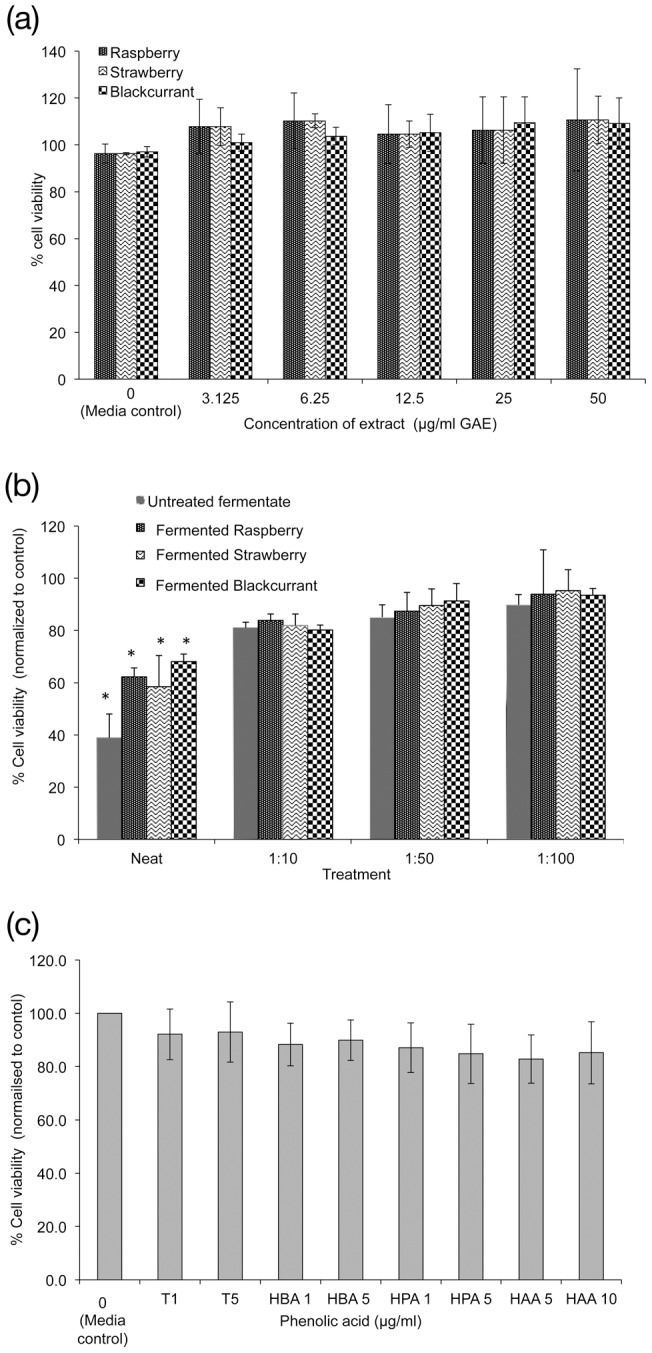
The cytotoxic effects of various types of berry extracts on HT29 cells.(A) Effects of IVD berry extract, (B) fermented berry extract at different dilutions in growth medium, (C) individual polyphenols- tyrosol (T), 3-(3′-hydroxyphenyl)propionic acid (HPA), 4-hydroxybenzoic acid (HBA), 4′-hydroxyphenylacetic acid (HAA) at 1, 5 or 10 µg/mL concentrations. Data presented is mean of 3 independent experiments + SD. One-way ANOVA and Dunnett T test, * p<0.05, significance is compared to media control (0 ug/mL) for A & C and against control fermentate in B. Phenol levels for 1∶10 dilution of fermented extract were raspberry 15.5, strawberry 13.9 and blackcurrant 12.4 µg/mL GAE.